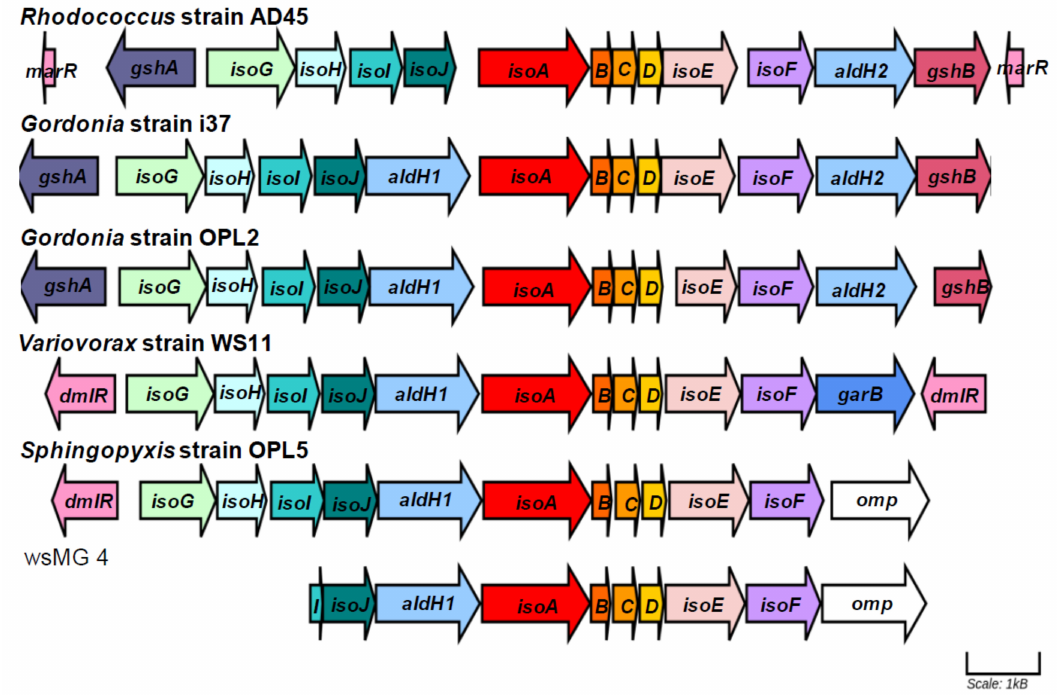
Figure 3. Isoprene metabolic gene clusters. Isoprene metabolic gene clusters in isoprene-degrading isolates (including Sphingopyxis strain OPL5 and Gordonia strain OPL2 isolated in this study), and a representative contig with the iso gene cluster obtained from metagenome co-assembly of 13 C-DNA from isoprene-enriched willow soil (wsMG4). The isoA gene that codes for the alpha-subunit of the monooxygenase is shown in red. The % identity of iso gene-encoded polypeptides to the corresponding Iso polypeptides of the well-characterized Rhodococcus strain AD45 are shown in Table S2 . omp : outer membrane protein